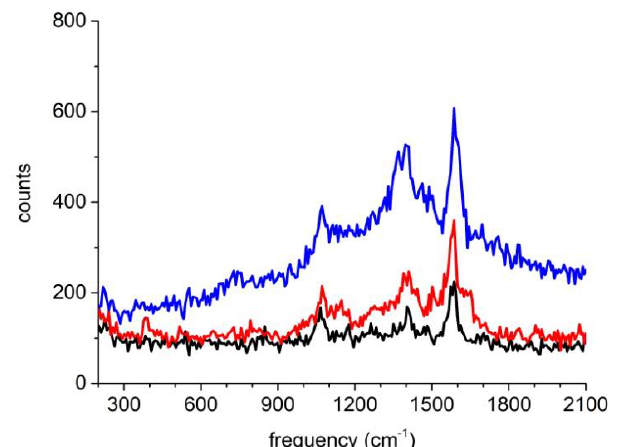
Figure 5. SERS spectra of a dimer structure measured continually at the fixed laser power setting of 0.8 mW (with the time order from black curve, next red curve, then blue curve).